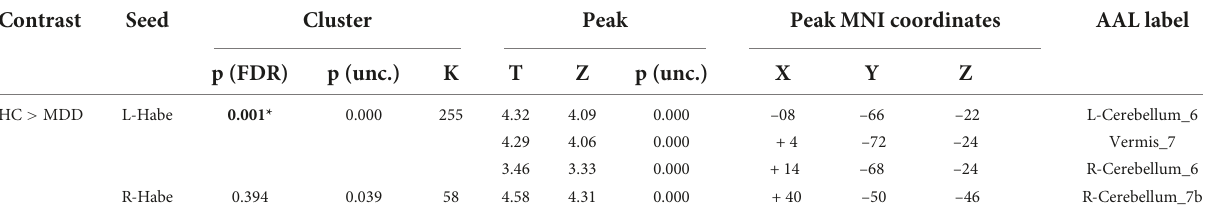
TABLE 2 Seed-to-voxel connectivity results with both habenula seeds.